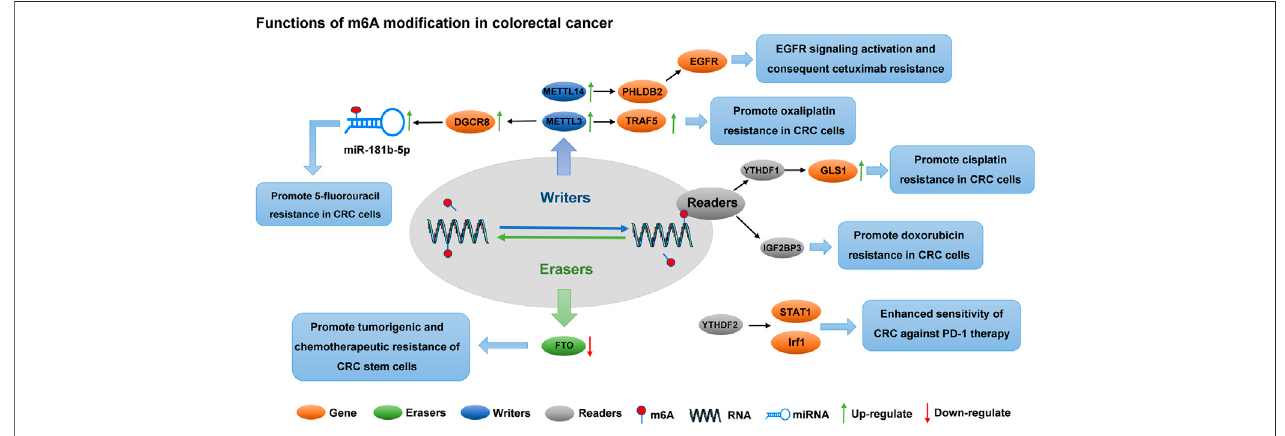
FIGURE4| Theregulatorymechanismofm6Amodi fi cationonchemotherapyresistanceinCRC.InCRC,m6AWriters,Erasers,andReadersaredysregulatedand promote CRC resistance to cisplatin, 5- fl uorouracil, oxaliplatin, doxorubicin, and targeted agents by regulating the stability of downstream gene expression.